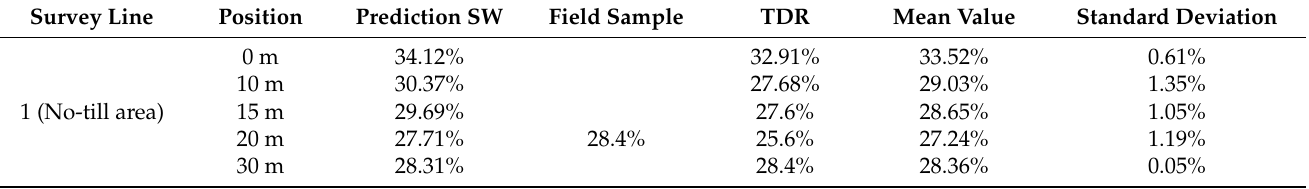
Table 5. Detailed information about VSWC values obtained by different methods at a depth of 15 cm. Survey